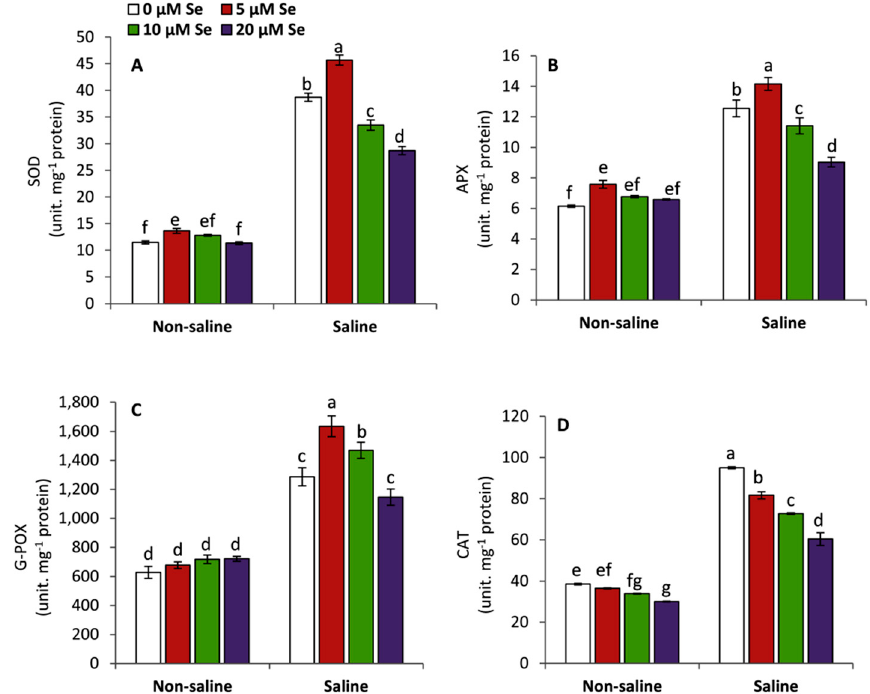
Figure 5. Effect of Se supplementation at 5, 10 and 20 µM on the activity of superoxide dismutase; SOD ( A ), ascorbate peroxidase; APX ( B ), guiacol peroxidase; G-POx ( C ) and catalase; CAT ( D ) of non- stressed and salt-stressed (50 mM NaCl) snap bean seedlings (28 days after sowing). The results are expressed as mean values of three measurements ± SE using Duncan’s multiple range test ( p = 0.05). Different letters indicate significant differences among the treatments.